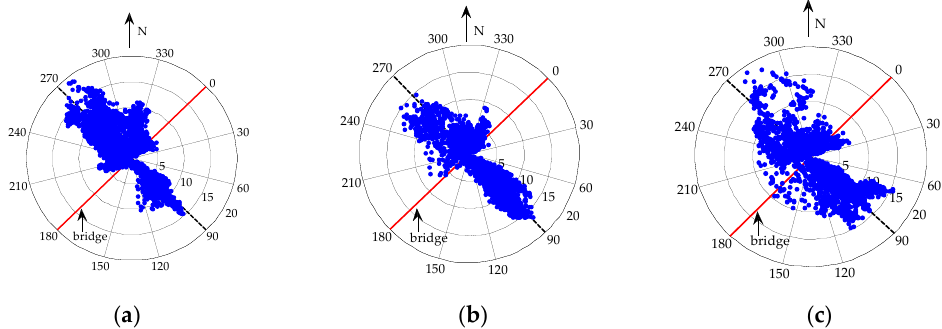
Figure 18. Wind rose diagramof XHM Bridge in di ff erent months: ( a ) January; ( b ) May; ( c ) August.